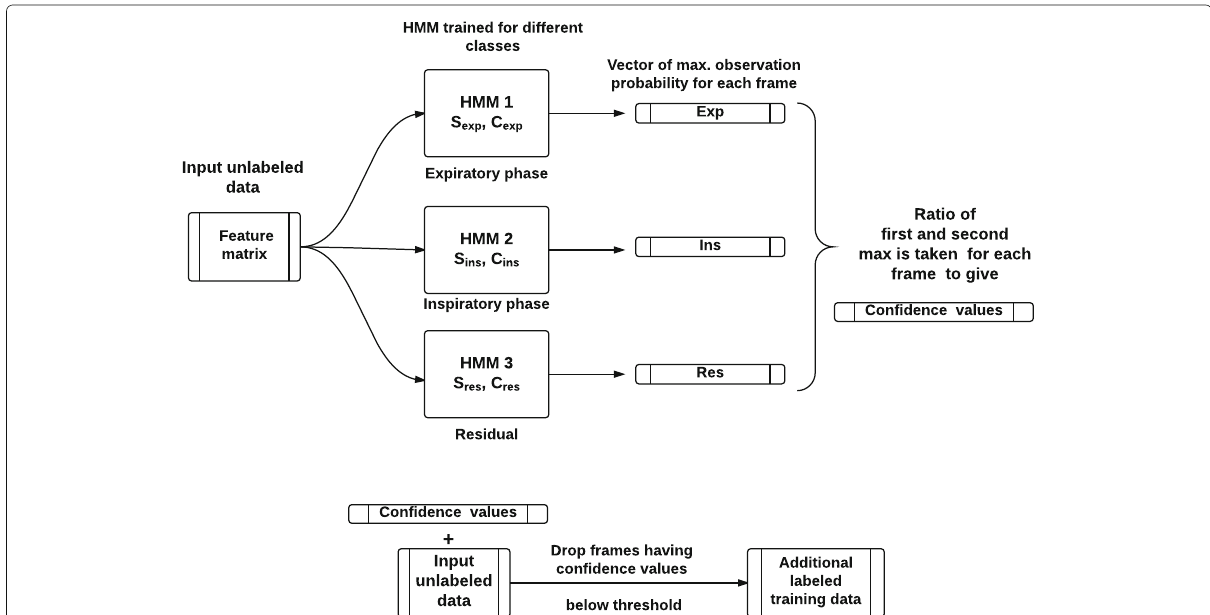
Fig. 7 Selection of data based on confidence threshold for each unlabeled audio file. The model outputs provide the labels for semi-supervised